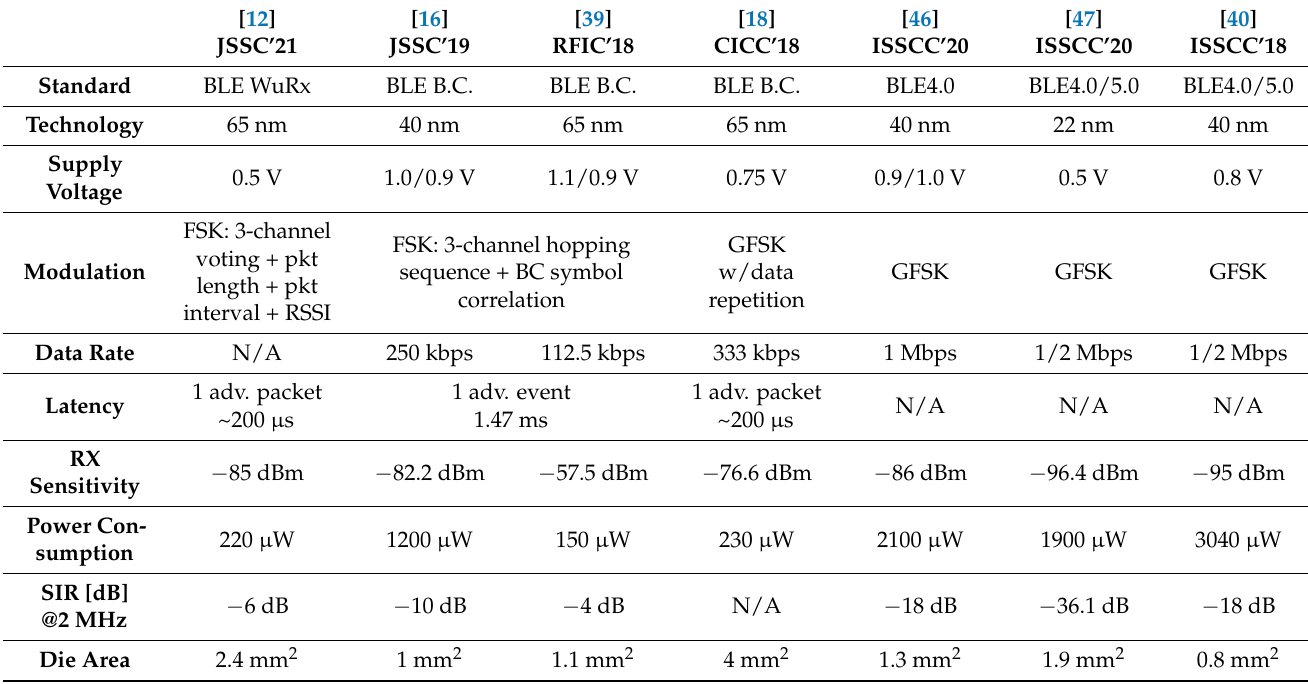
Table 1 summarizes the trade-off between power and other performance metrics in BLE receivers. The table shows the performance of back-channel BLE receivers in comparison with fully-compliant BLE receivers [36–47]. It can be seen that state-of-the-art fully compliant receivers consume around ~2 mW, while BLE back-channel receivers have power consumption as low as ~200 µ W. The receiver data rate, sensitivity at BER of 0.1% and adjacent channel rejection are lower in the case of back-channel BLE receivers which can be acceptable for some targeted applications. To sum up, there is still a room for innovation to improve the performance of low power radios. Table 1. Comparison table for the state-of-the-art Bluetooth-Low Energy receivers.